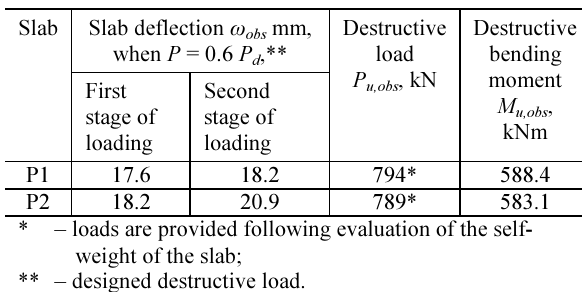
Destructive Destructive load bending P u,obs , kN moment M u,obs , kNm